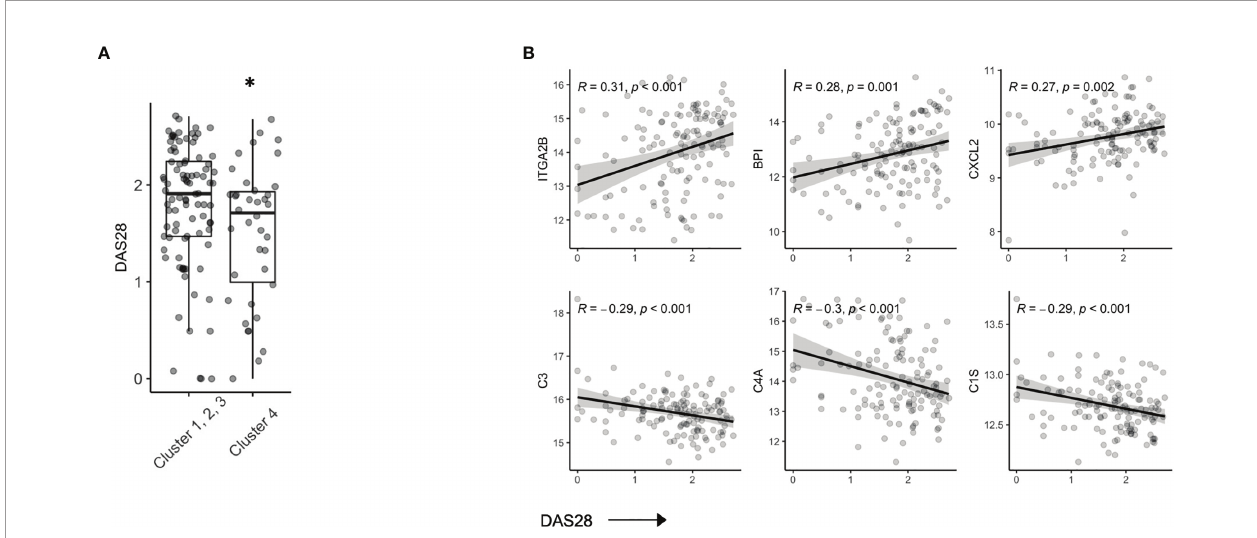
FIGURE 3 | Serum proteins are associated with DAS28 in stable RA. (A) Box plots of DAS28 disease scores in patients, split by cluster assignment (p = 0.03). (B) Correlation plots of DAS28 and serum protein expression of ITGA2B, BPI, CXCL2, C3, C4A, C1S. *p <